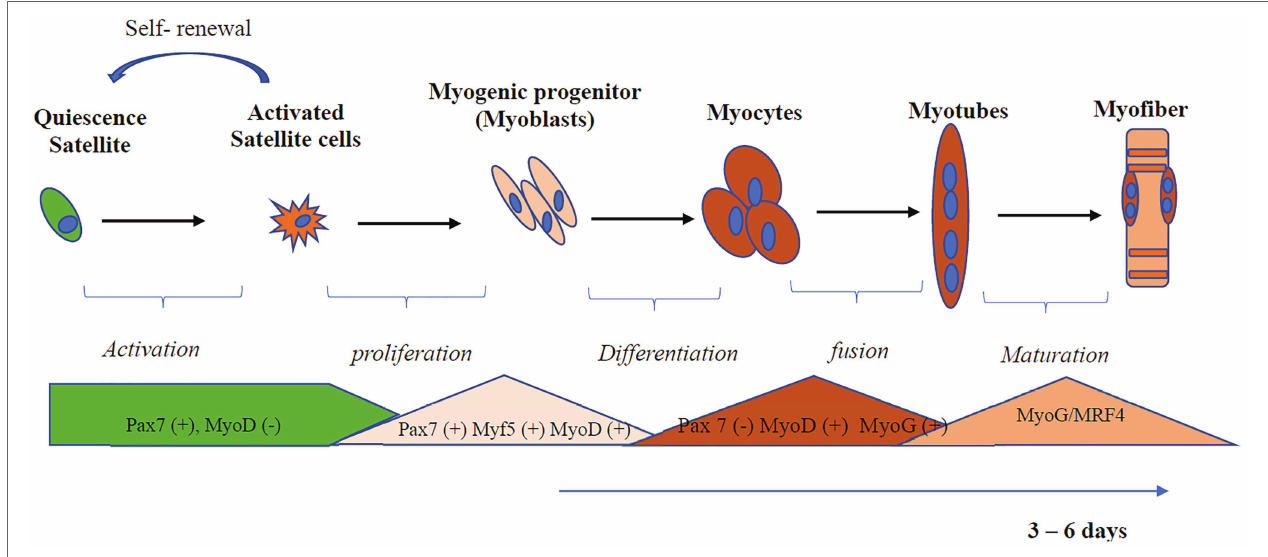
FIGURE 1 | Activation and differentiation of skeletal muscle satellite cell (SC). SCs in an undamaged adult muscle are maintained in a quiescent and undifferentiated state. Quiescent SCs are characterized by the expression of Pax7. Myoblast determination protein 1 (MyoD), a master gene for myogenesis, is expressed at an early stage of myogenic differentiation and induces the expression of other myogenesis-related genes, such as myogenin (MyoG) and MRF4. Myoblast undergoes differentiation and fusion under appropriate conditions from myotubes. Myf5 , Myogenic factor 5; MyoD, myoblast determination protein 1; MyoG, myogenin; MRF, myogenic regulatory transcription factor; Pax, Paired box